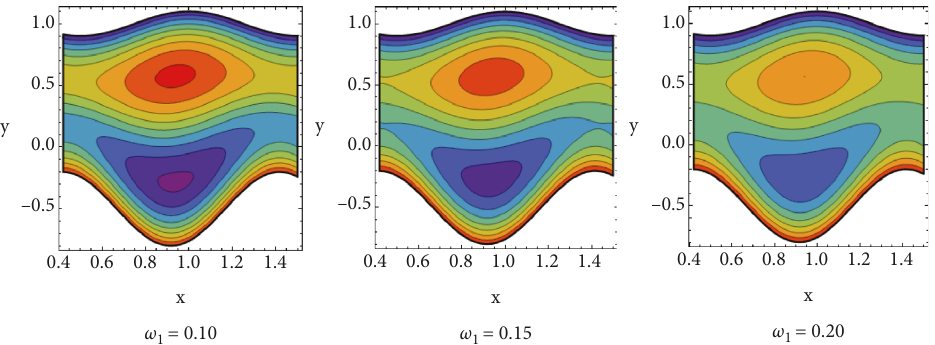
Figure 9: Impact of streamlines on ω